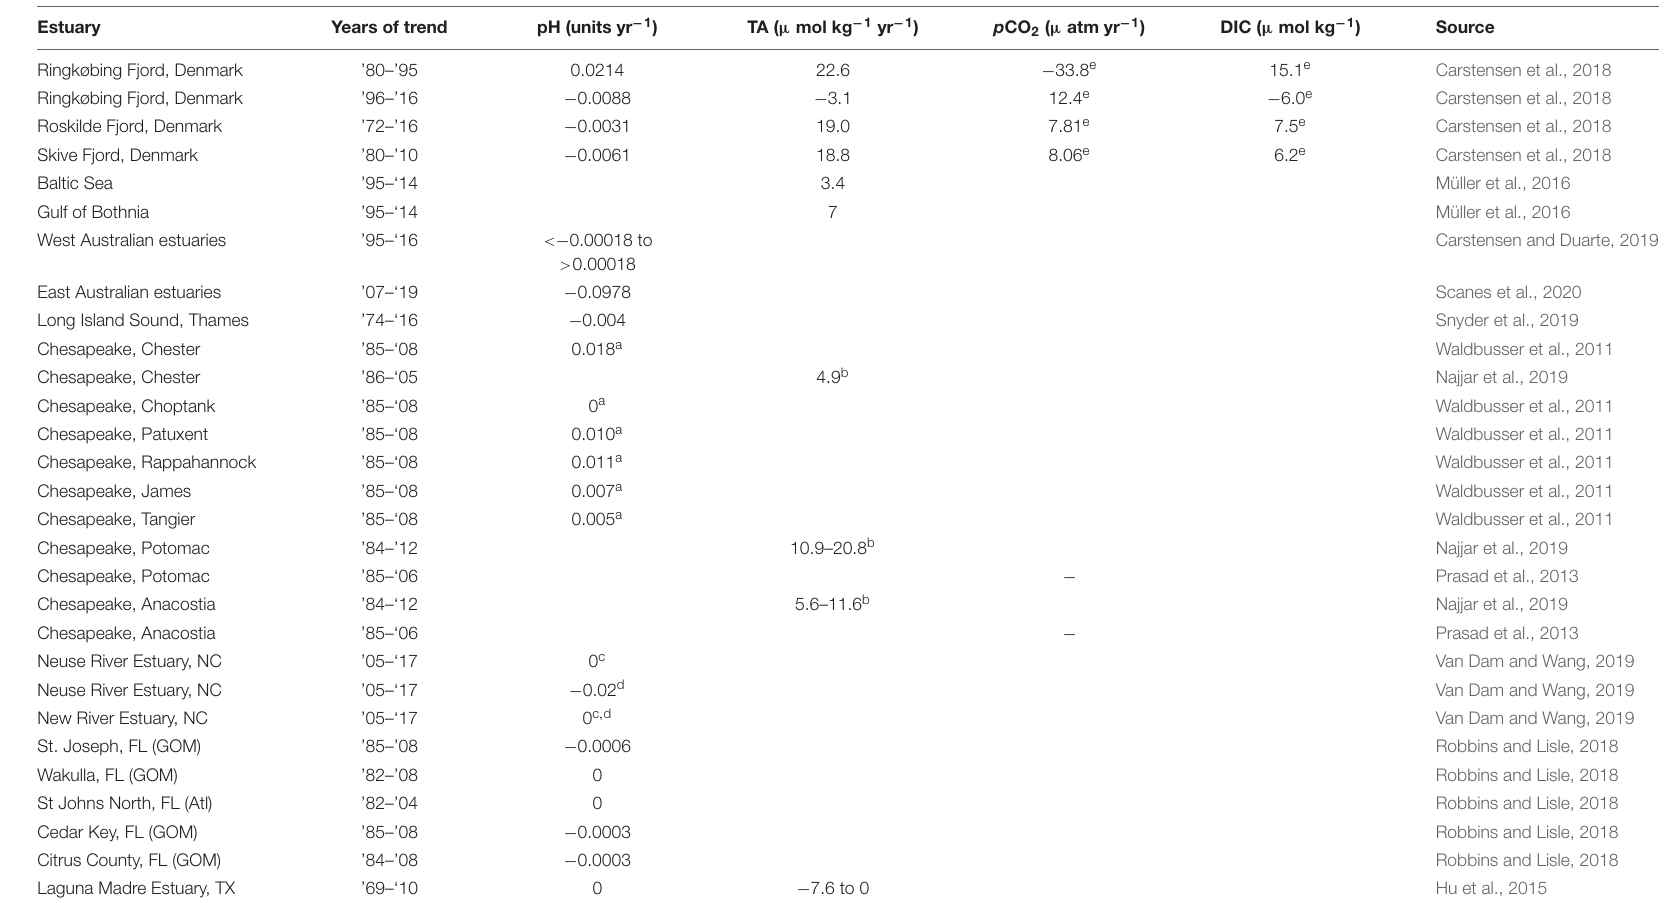
TABLE 1 | Long-term trends in carbonate chemistry parameters that have been previously reported in estuaries around the world. Estuary Years of